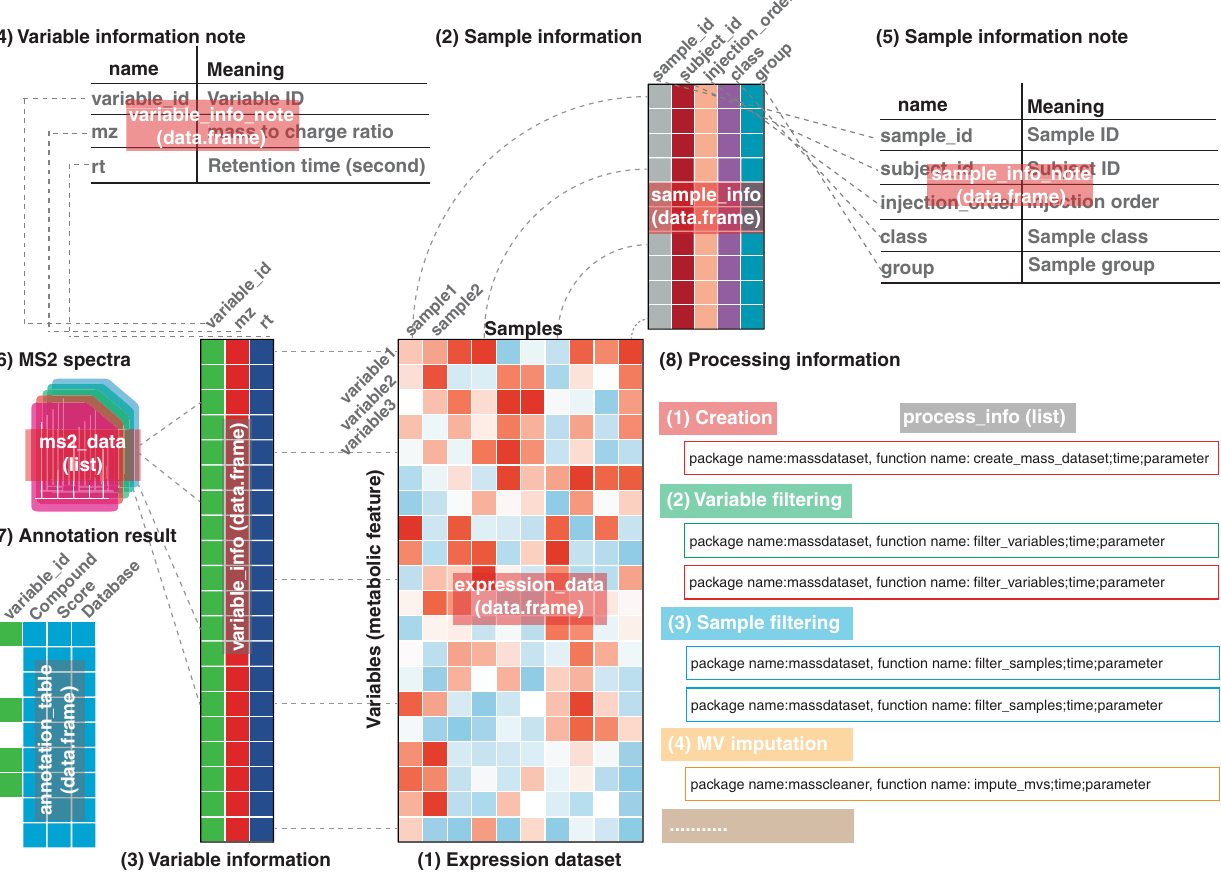
Fig.2|The “ mass_dataset ” classanditscomponents. The “ mass_dataset ” classis a uniform data infrastructure, which is speci fi cally designed for representing metabolomics data. Most functions in the tidyMass accept this class as their input